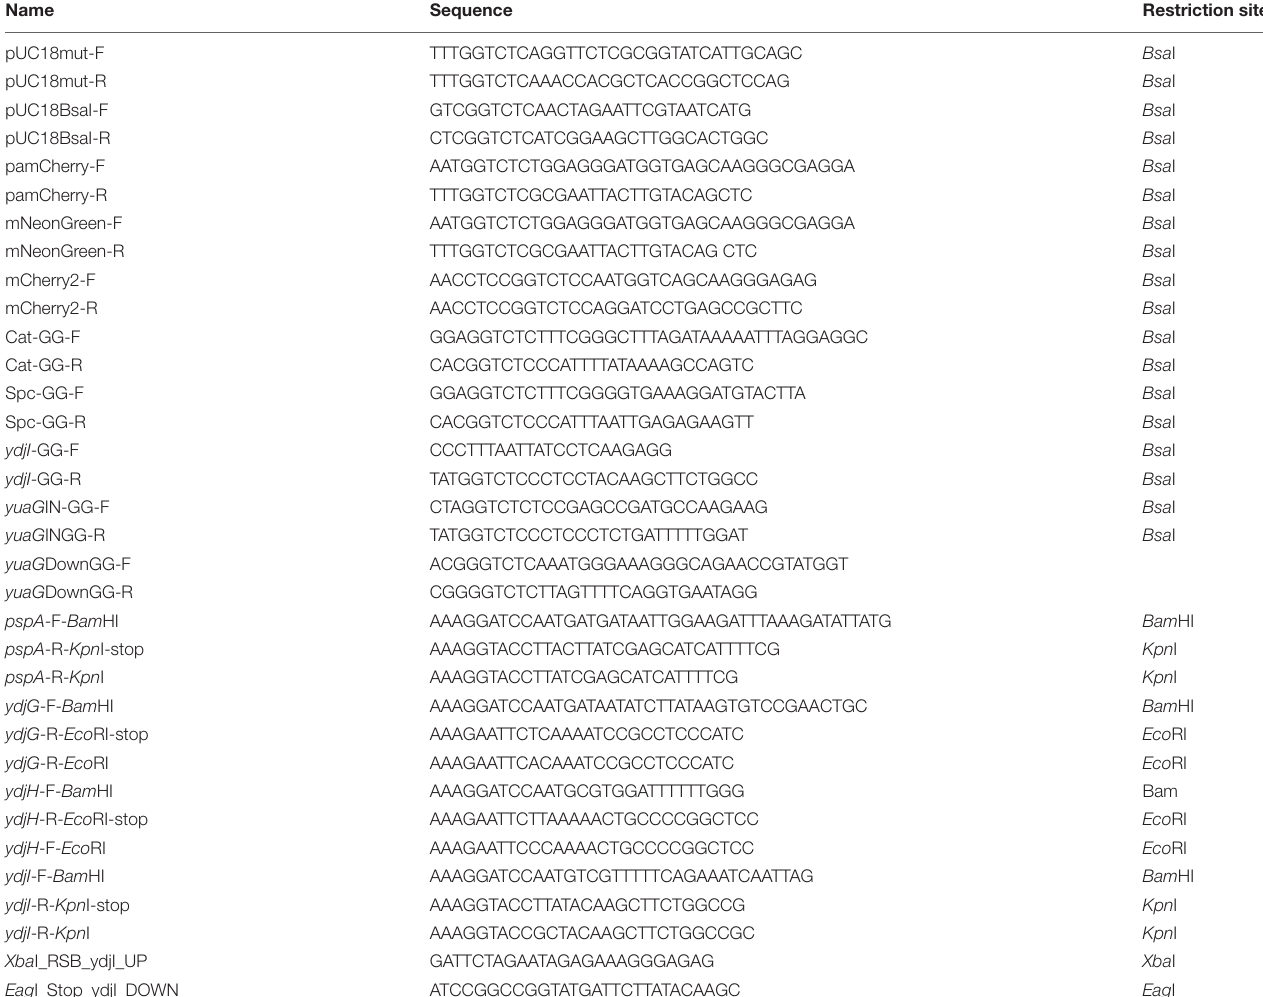
TABLE 4 | Oligonucleotides used in this